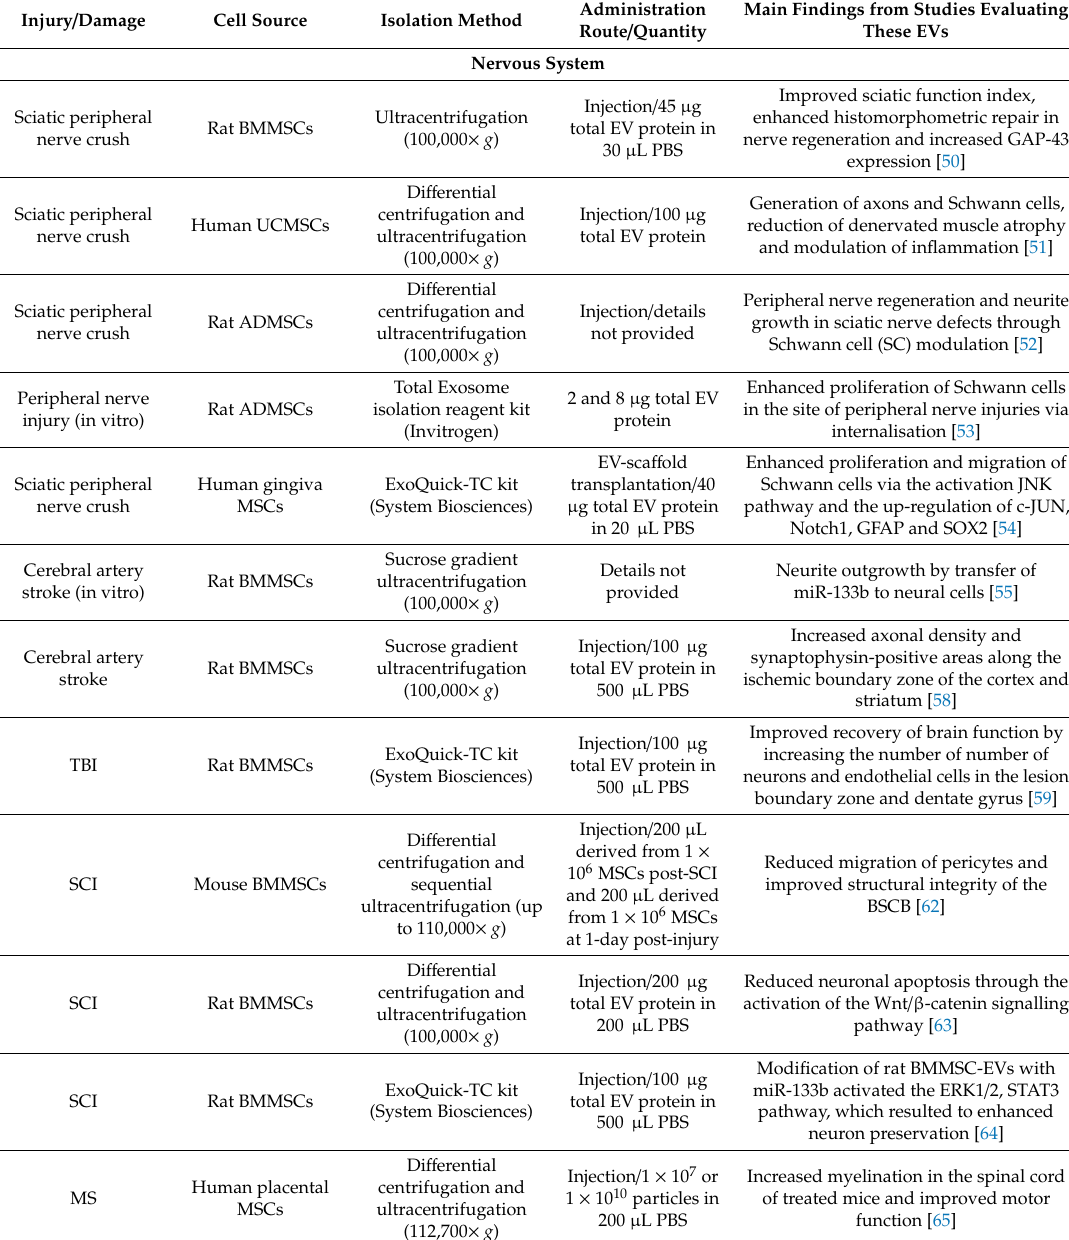
Table 1. MSC-EVs in tissue engineering and regenerative medicine